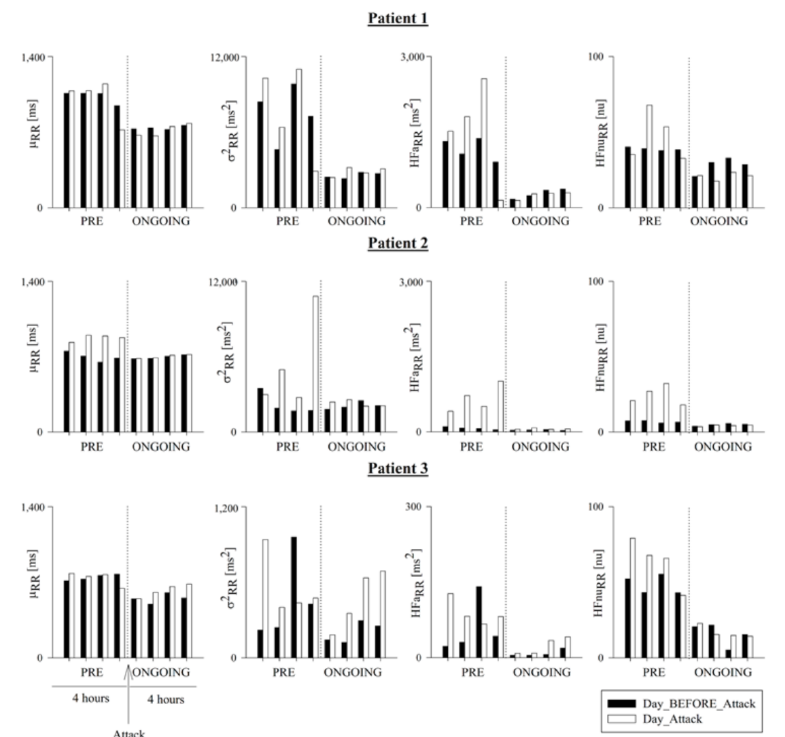
Figure 4. Temporal evolution of time and frequency domain HRV markers in Patients 1, 2 and 3. Bar graphs show the RR mean ( µ RR ), RR variance ( σ 2 RR ), and the absolute (HFa RR ) and normalized (HFnu RR ) power in the HF band in Patient 1 (upper panels), Patient 2 (middle panels), and Patient 3 (lower panels). Indices were calculated hour-by-hour in the 4 h preceding (PRE) and the first 4 h following the onset of the HAE attack (ONGOING) on the day of the attack (Day_Attack, white bars) and compared to data during the same circadian phase on the day before (Day_BEFORE_Attack, black bars). Results are shown as mean ± standard